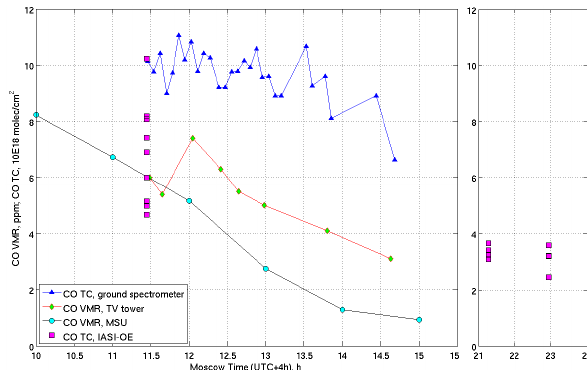
Fig. 8. Moscow, 9 August 2010. CO TC retrieved from spectra of ground spectrometer (blue triangles) are plotted in units × 10 18 moleccm − 2 . Also plotted are CO VMR in ppm in the surface layer, MSU, and the data for the TV tower averaged over the altitudes 0–248m above the surface. Squares correspond to IASI- OE data for the Moscow 1 ◦ × 1 ◦ grid cell centered at 55.5 ◦ N and 36.5 ◦ E.